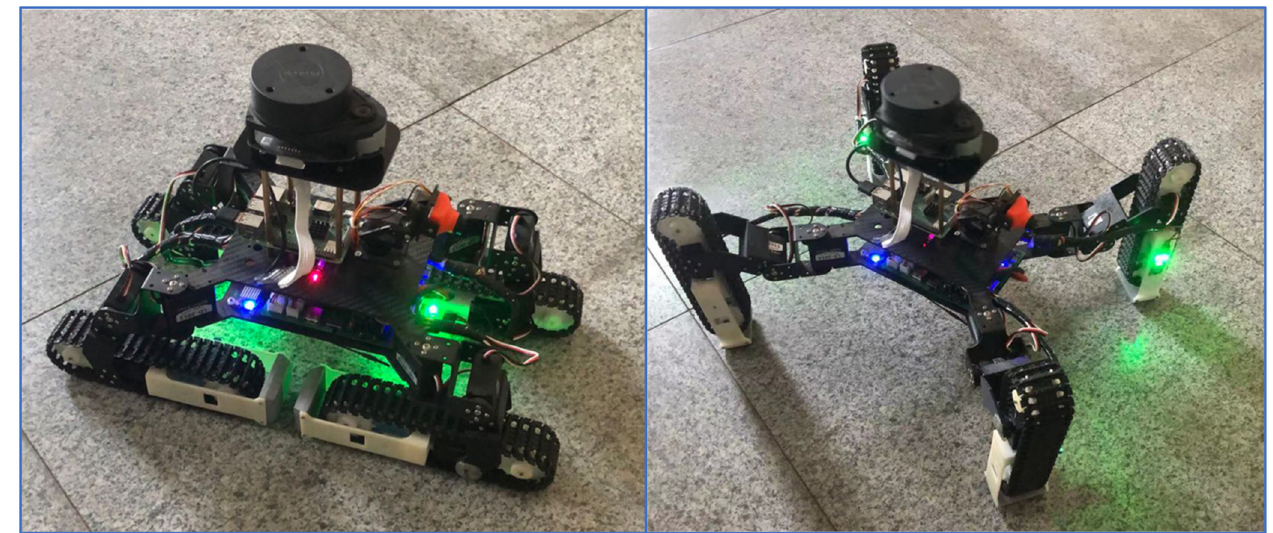
Figure 4. TALBOT, a quadruped robot with 3-DOF legs, in tracked mode ( left ) and in legged mode ( right ).